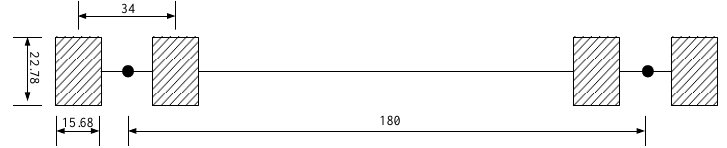
Figure 6. Schematic diagram of load arrangement (unit: cm).